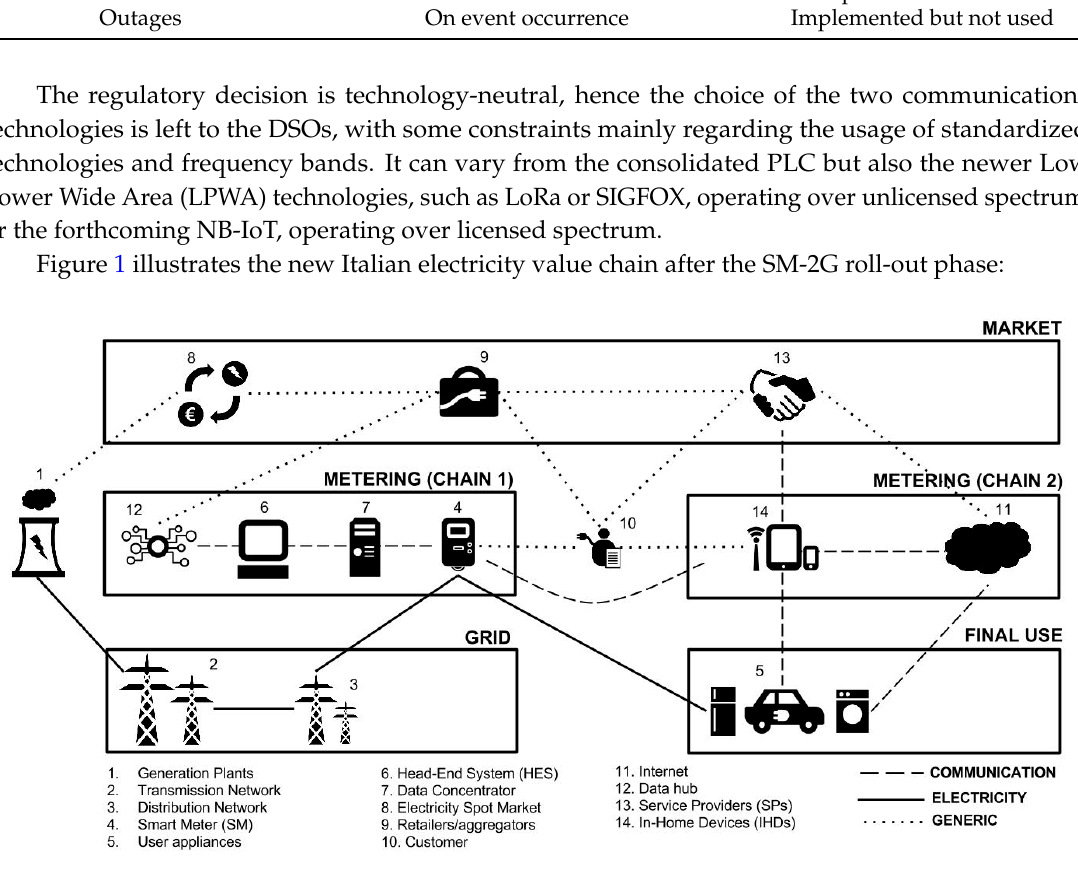
Figure 1. Electricity value chain for second generation Smart Meters (SM-2G).